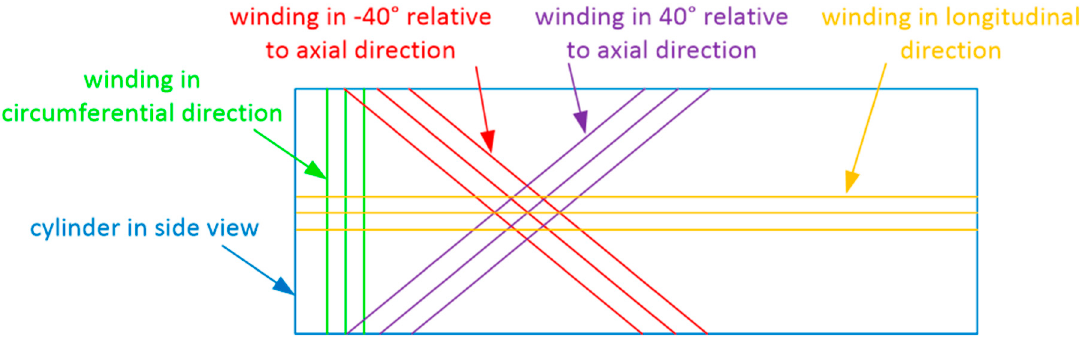
Figure 7. Qualitative illustration of the different winding directions that can be applied in the manufacturing process of a carbon fibre-reinforced plastic (CFRP) cylinder (the angles are only examples for illustrating the concept).